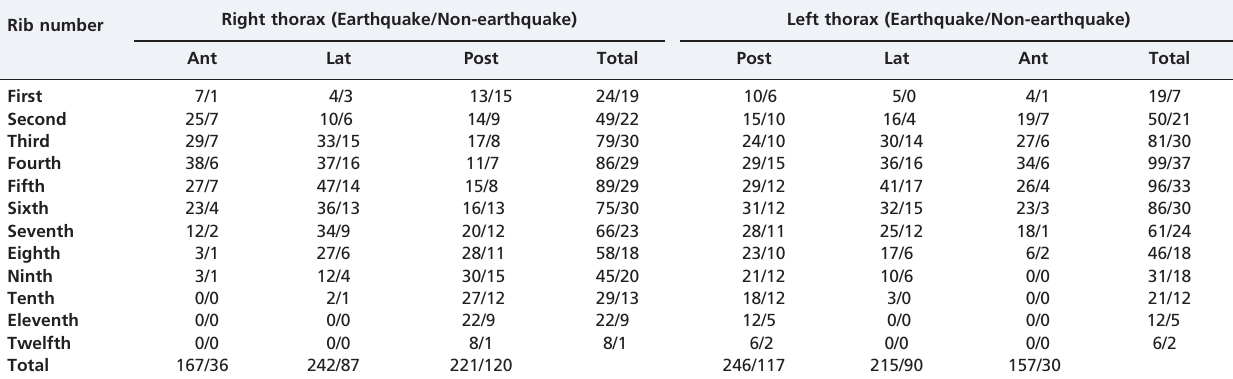
Table 3 - Anatomic Distribution of Rib Fractures in Earthquake-related Thoracic Crush Traumas vs. Non-earthquake Traumas (ribs). Rib